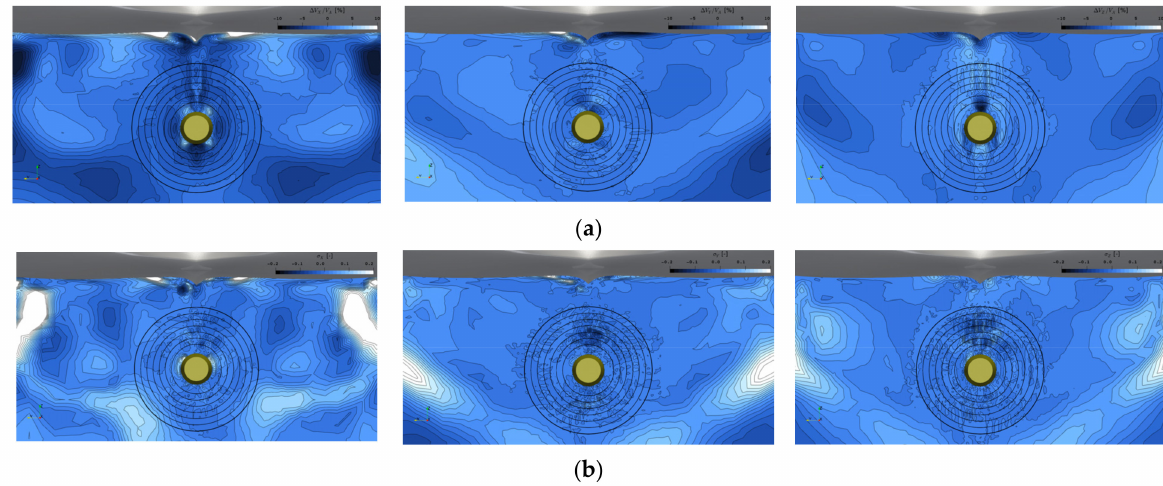
Figure 14. SCHOTTEL reference case 1. Differences between the RANS and ILES wake fields in terms of Cartesian components x, y and z, velocities are averaged over one rotation, the propeller plane is indicated by radii sections: ( a ) velocity difference; ( b ) velocity standard deviation difference.